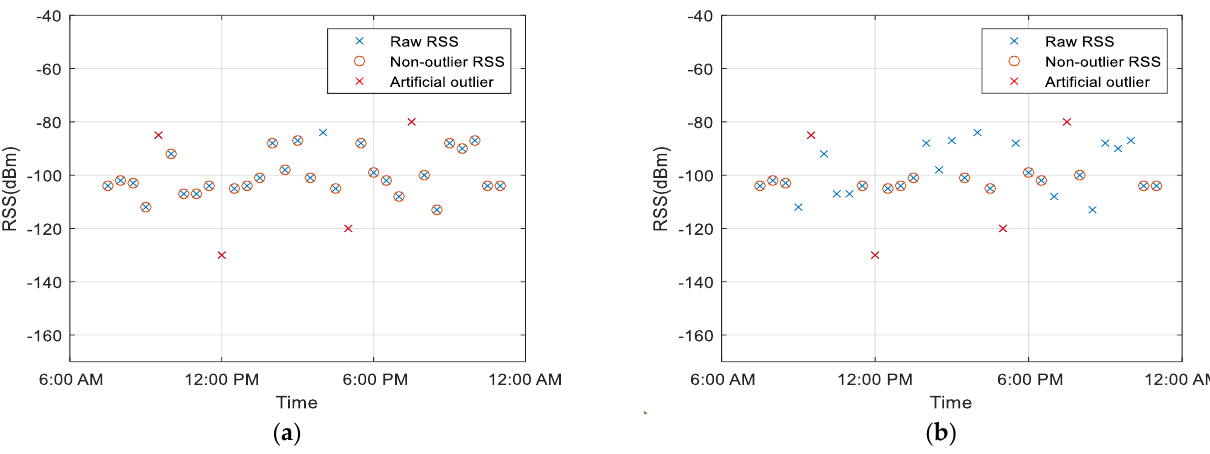
Figure 13. Outlier detection comparison of RSS Dataset 2 with and without artificial outliers for: ( a ) 𝑆 𝑛 scale estimator ( b ) MAD scale estimator.